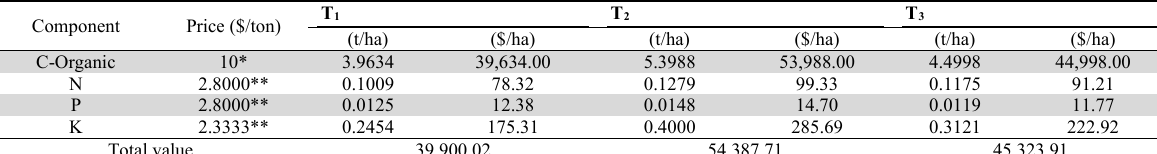
The Indirect Use Value of Rice Straw Biomass